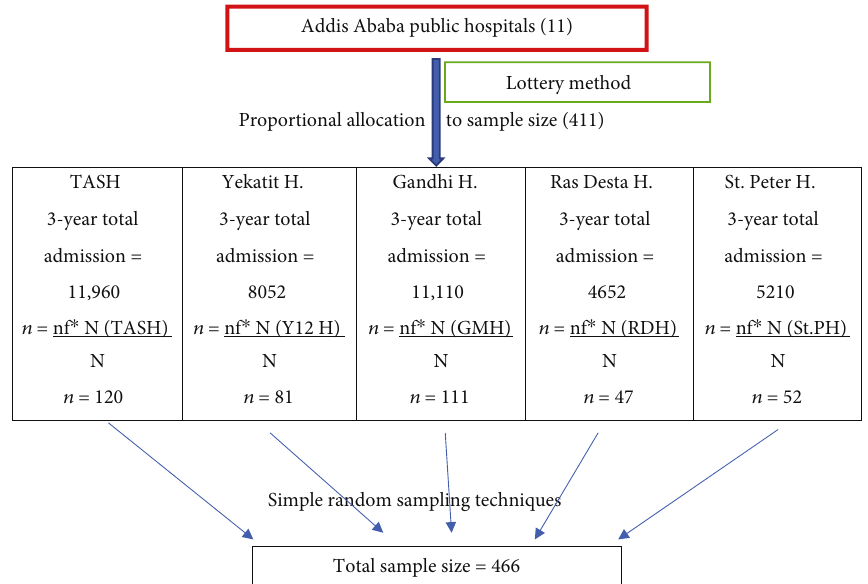
Figure 1: Schematic presentation of sampling procedure on proportion of admission hypothermia and outcomes of hypothermic preterm babies admitted in Addis Ababa public hospitals from 2018 to 2021, Addis Ababa, Ethiopia,